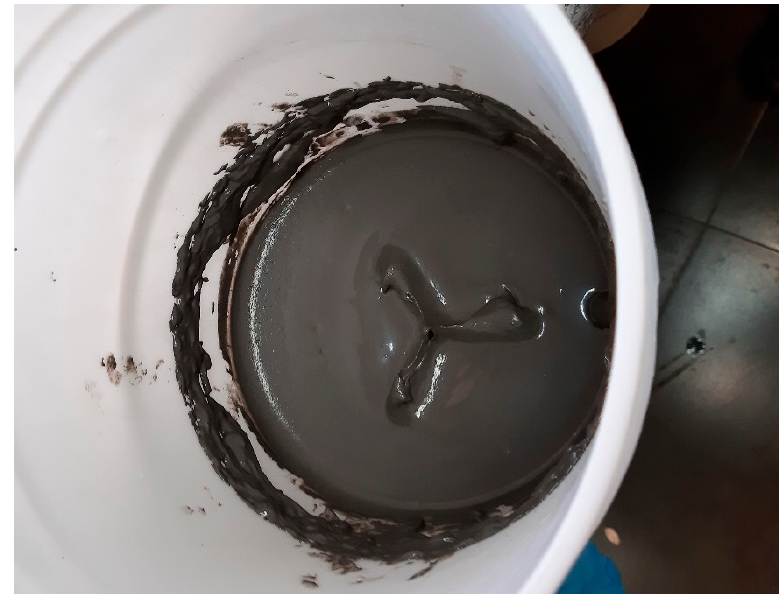
Figure 8. Consistency of Method II, 1 day set at room temperature.